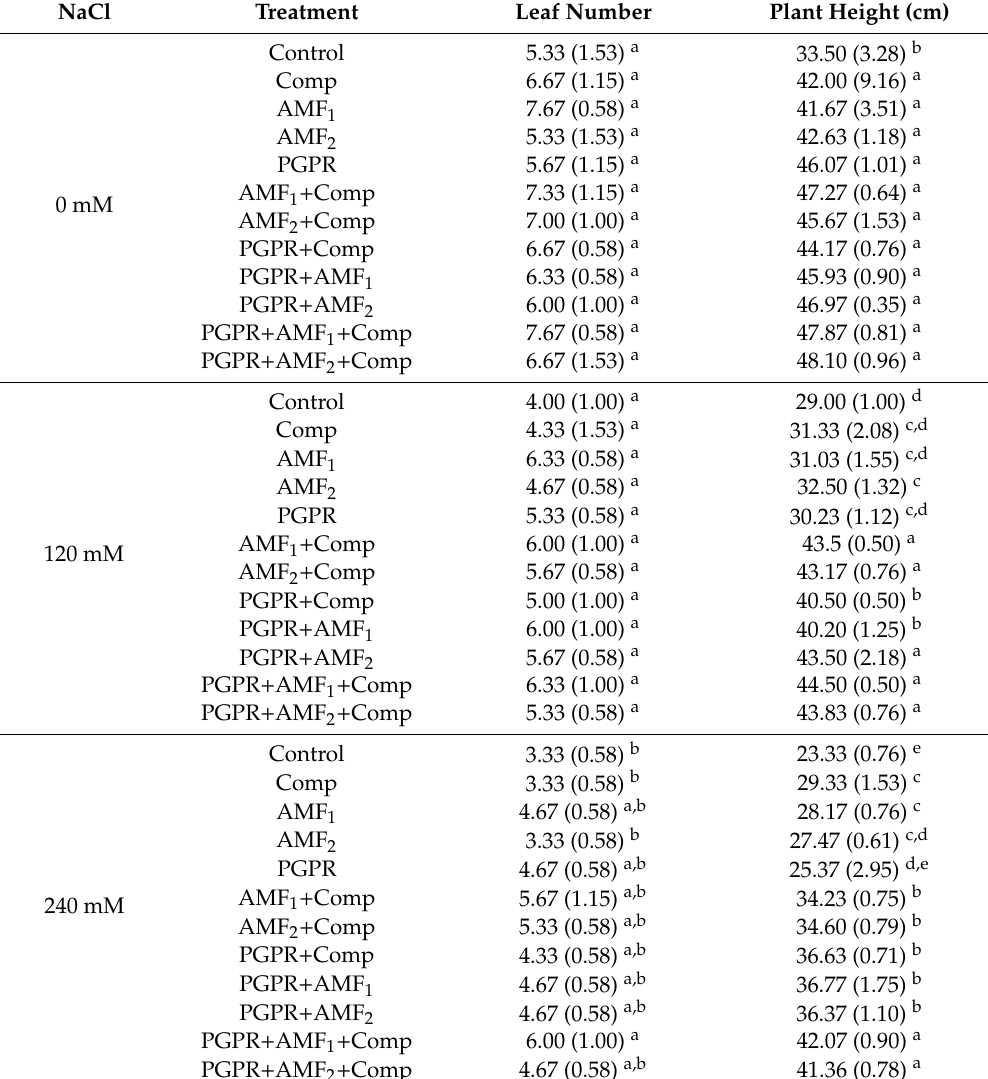
Table 2. E ff ects of biofertilizers on growth parameters of date palm vitroplants under di ff erent salt (NaCl) stress levels, 0, 120 and 240